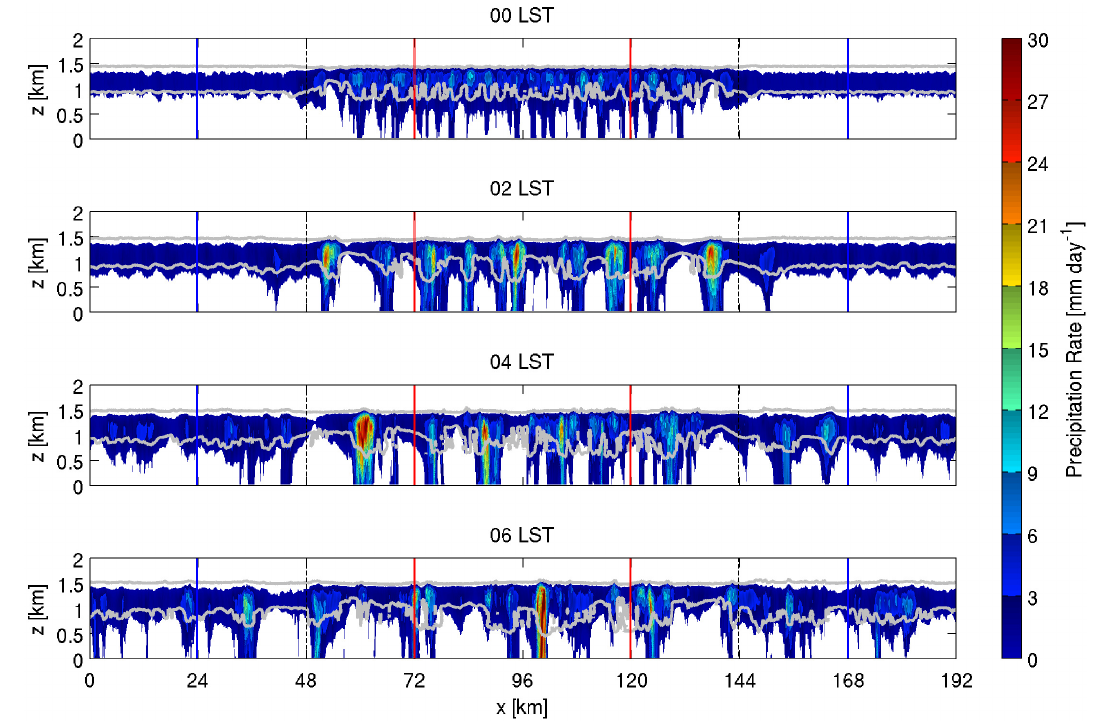
Fig. 10. y -averaged x - z snapshots of the precipitation with the q c = 0 . 01gkg − 1 contour overlaid to show cloud structure.